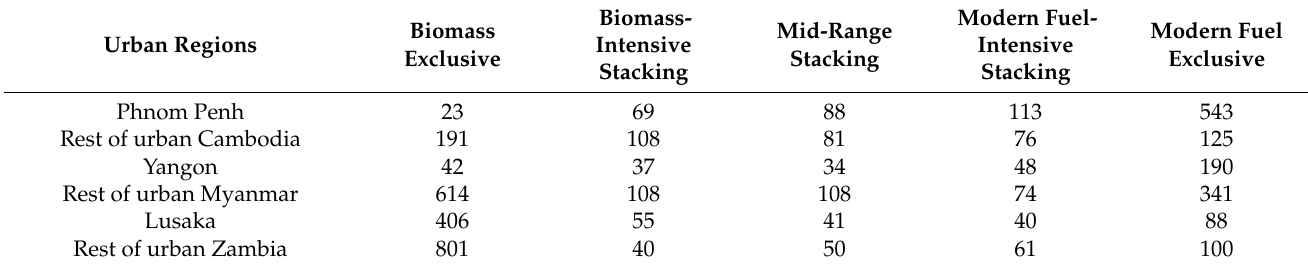
Table 4. Number of surveyed households residing in urban areas, categorised by cooking fuels and the proportion of household spend on these